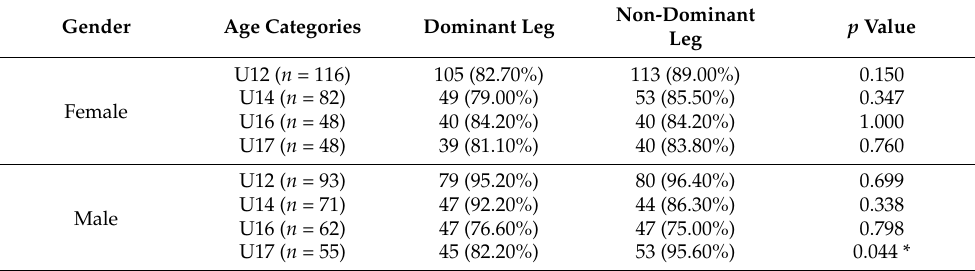
Table 4. Dynamic lower extremity valgus for between-group comparisons of U12 to U17 basketball